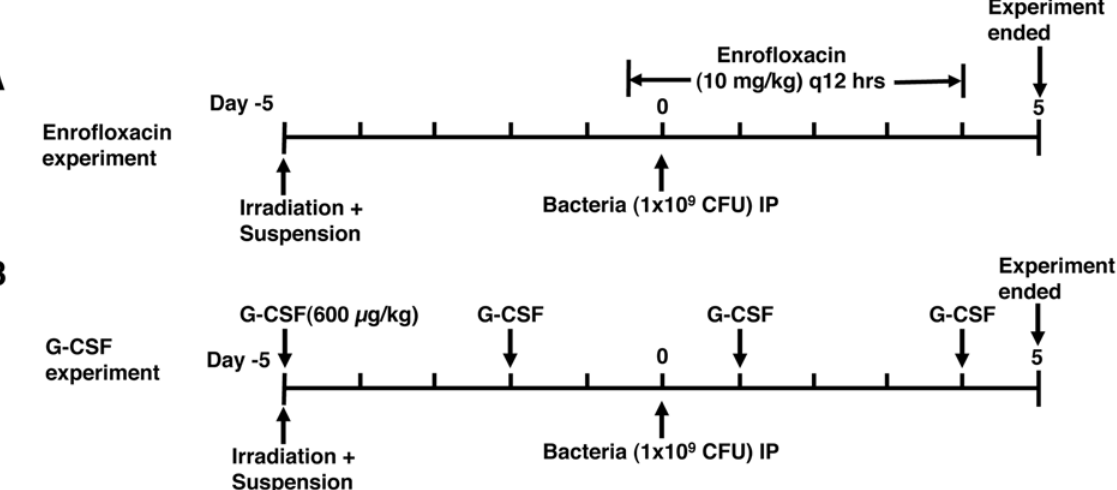
Fig 1. Diagram of experimental procedure. Groups of 10 mice per treatment condition were irradiated or sham with 2 Gy of proton or gamma radiation and then hindlimb suspended or not. (A) Mice began treatment with enrofloxacin (10 mg/kg) subcutaneously 12 hrs before bacterial challenge and were dosed every 12 hrs. (B) Mice began treatment with G-CSF (600 μ g/kg) subcutaneously after irradiation and suspension and were dosed every 3 days. Five days post-irradiation, mice were challenged with Pseudomonas aeruginosa (10 9 CFUs, IP). Mice were followed for 5 days and blood was obtained for quantitation of bacterial CFUs and